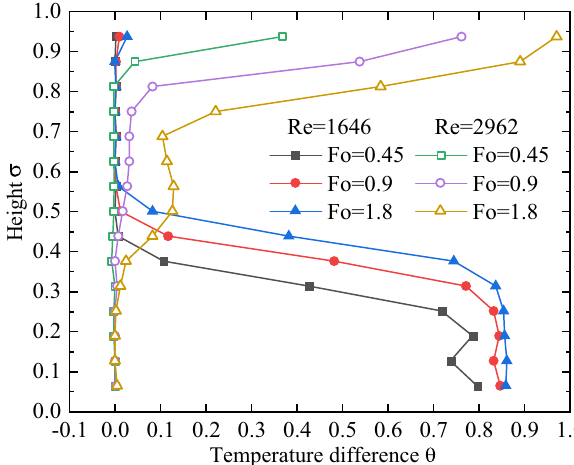
Fig. 7 Temperature change of L1 with time under different Re numbers in forward flow